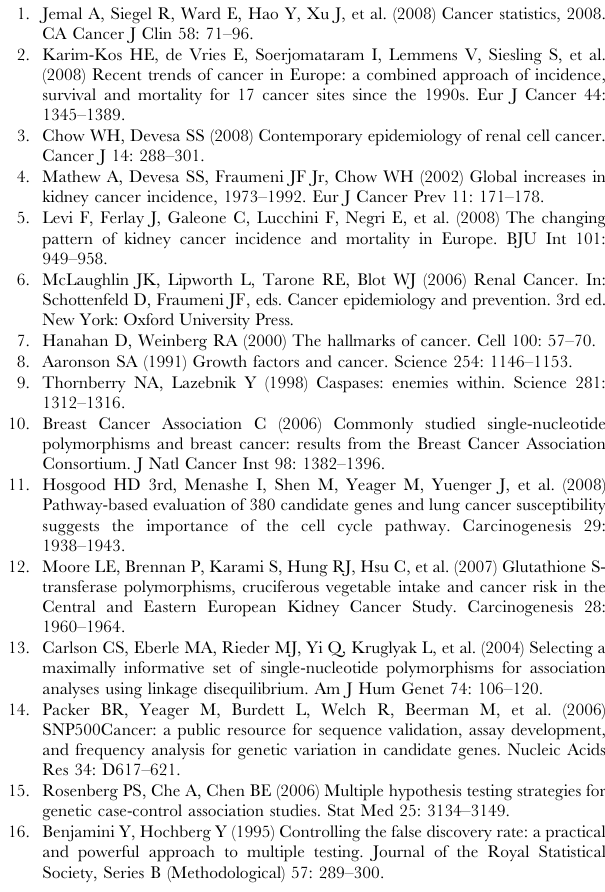
Figure S3 Sliding window results and linkage disequilibrium plot of IGFBP3 region. The haplotype results reported in Table 3 are indicated by a line depicting each region. Upper portion of figure presents global p-value associated with each 3 SNP sliding window, unadjusted and FDR-adjusted. Lower portion of figure presents linkage disequilibrium plot with color scheme based on D’ and logarithm of the odds of linkage (LOD) scores. Numbers in the squares are r2 values. Table S1 Results from all Growth and Differentiation, Apopto- sis Polymorphisms and Renal Cell Cancer Risk. Table S2 EGFR integrated haplotype and renal cancer